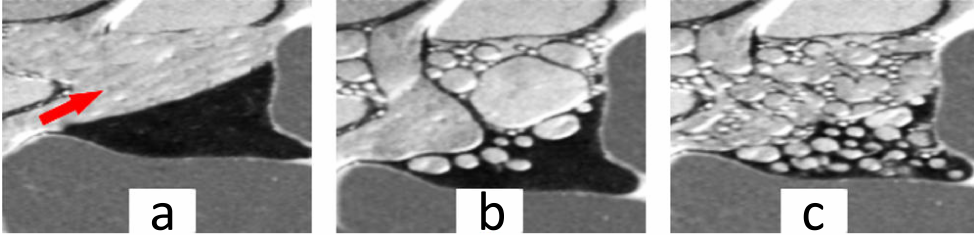
Figure 22. Residual oil displacement in a dead-end being swept by different fluids: ( a ) brine, ( b ) SDS foam, and ( c ) SiO 2 /SDS foam flooding. Figure reproduced from Ref.